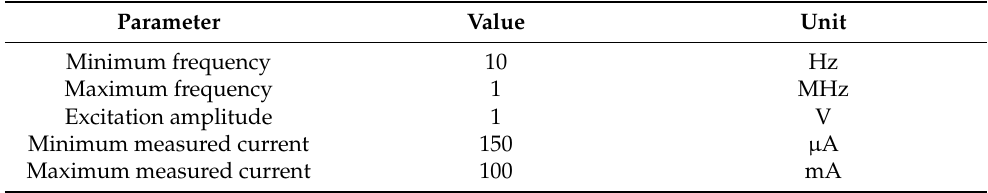
Table 1. Settings used for EIS